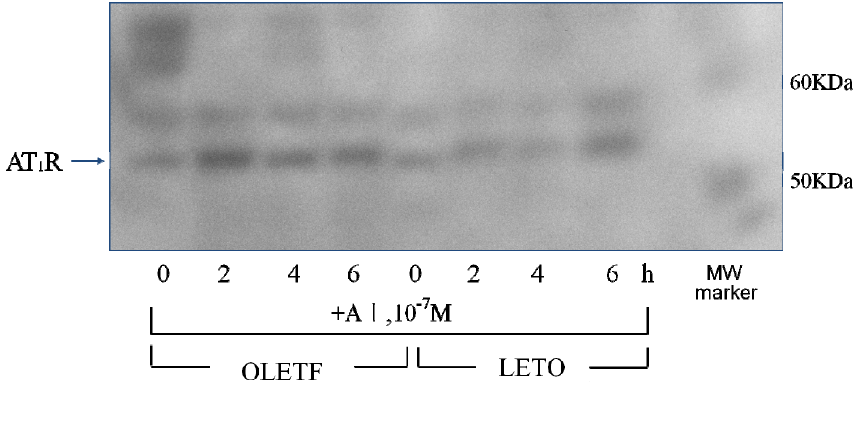
Figure 7. Effect of angiotensin I on AT1R protein expression. Rat AoSMC were incubated with 10 − 7 M angiotensin I for 2, 4 and 6 h. The pelleted cells were soon solubilized and subjected to SDS-PAGE using a linear gradient of 10%–20% acrylamide gel. All proteins were electrophoretically transferred to nitrocellulose membranes and analyzed using standard immunoblotting procedures. Molecular weight (MW) markers were run in the right